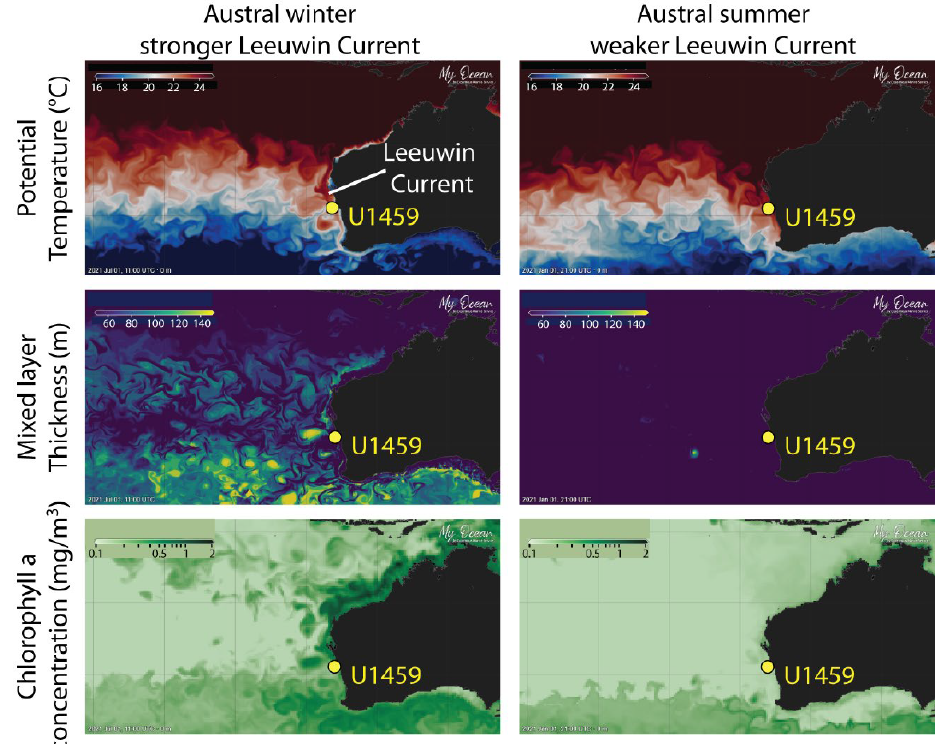
Figure B1. Present-day oceanography of the southeastern Indian Ocean. The southward flowing Leeuwin Current is strongest in late autumn and winter. During that season, the Leeuwin Current forms large eddies, causing significant deepening of the mixed layer (up to ∼ 200m) and facilitating enhanced primary productivity (shown here are data from 1 July 2021). During austral summer, the Leeuwin Current is weaker (shown here are data from 1 January 2021), with a thinner mixed layer and reduced productivity is reduced. Figure was generated using EU Copernicus Marine Service Information with https://resources.marine.copernicus.eu/product-detail/GLOBAL_ANALYSIS_FORECAST_ PHY_001_024/INFORMATION (last access: 22 May 2022) (Zammit-Mangion and Wikle, 2020) and https://resources.marine.copernicus. eu/product-detail/GLOBAL_ANALYSIS_FORECAST_BIO_001_028/INFORMATION (last access: 22 May